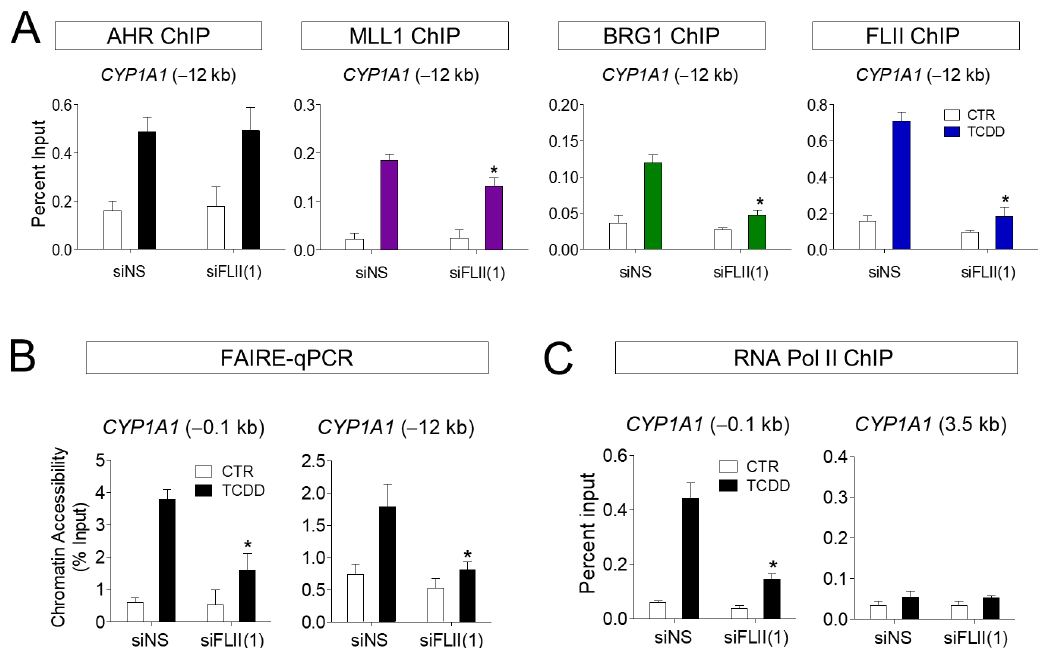
Figure 4. FLII is required for the chromatin structure at the CYP1A1 locus in ARPE-19 cells. ( A ) Chromatin immunoprecipitation assays in FLII-depleted ARPE-19 cells. ARPE-19 cells were transiently transfected with siFLII(1) or siNS for 48 h. The amount of the precipitated CYP1A1 enhancer fragments was determined by qPCR. ( B ) FLII is required for chromatin accessibility at the CYP1A1 enhancer region. Chromatin accessibility at the CYP1A1 enhancer was assessed by FAIRE-qPCR analysis using chromatin samples prepared from ARPE-19 cells transfected with siNS or siFLII(1) and treated with 10 nM TCDD or vehicle for 1 h. ( C ) Chromatin immunoprecipitation assay using an RNA polymerase II antibody was performed as in Figure 4A. 3.5 kb region of CYP1A1 was used as control. Data are presented as means ± S.D. (n = 3). * P < 0.05 vs. control.